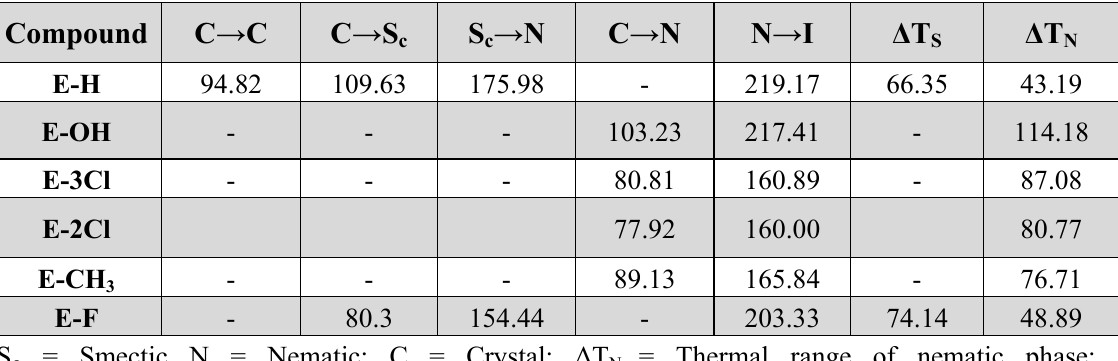
Table 1. The phase transitions of compounds ( °